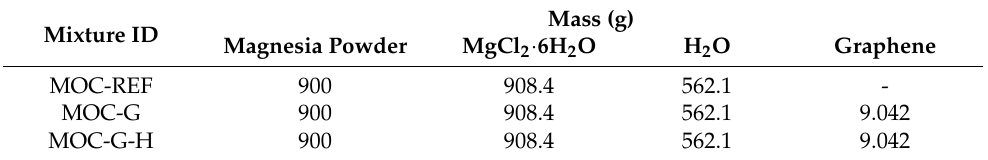
Table 1. Composition of tested paste